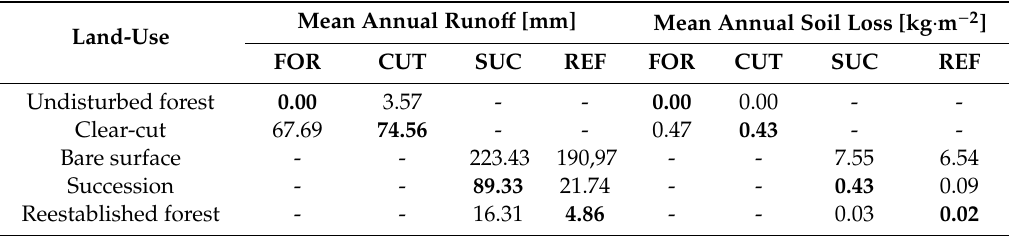
Figure 15. Modeling results (annual and storm) for (FOR)ested and (CUT)-down sites, using realistic slope geometry and di ff erent land managements. Table 17. Mean modeled annual runo ff and soil loss. Bold values represent current land